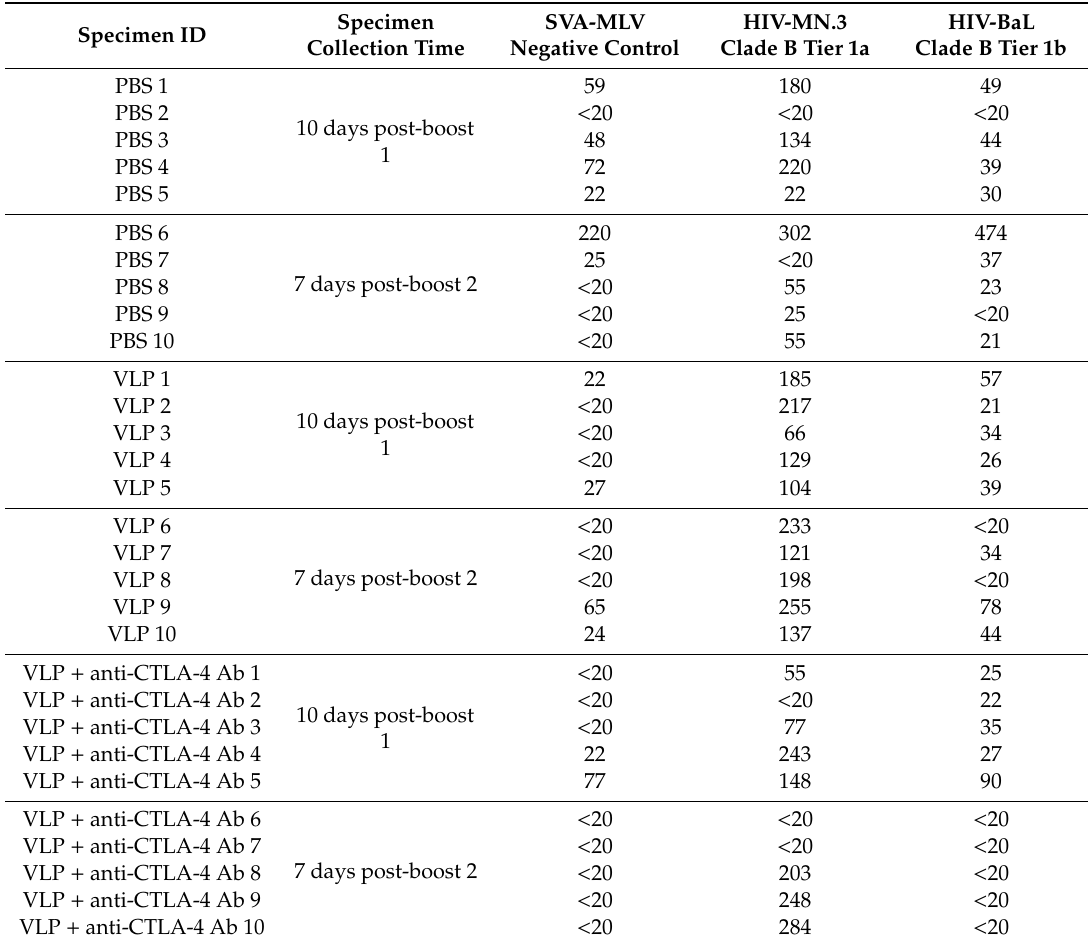
Table 1. Neutralizing antibody analysis. Serum samples collected at sacrifice from Cohorts 1 and 2 ( n = 30) were analyzed for neutralizing antibody activity using TZM-bl assay against the control virus SVA-MLV, HIV-BaL.26, and HIV MN.3. Values reported above are the serum dilution at which relative luminescence units (RLUs) were reduced 50% as compared with virus control wells (no serum). Titers against HIV are considered positive for neutralizing antibody activity based on the criterion of signal > 3x that against the negative control virus and > 3x the signal of animals in the vaccine control group. No statistical di ff erences were found between